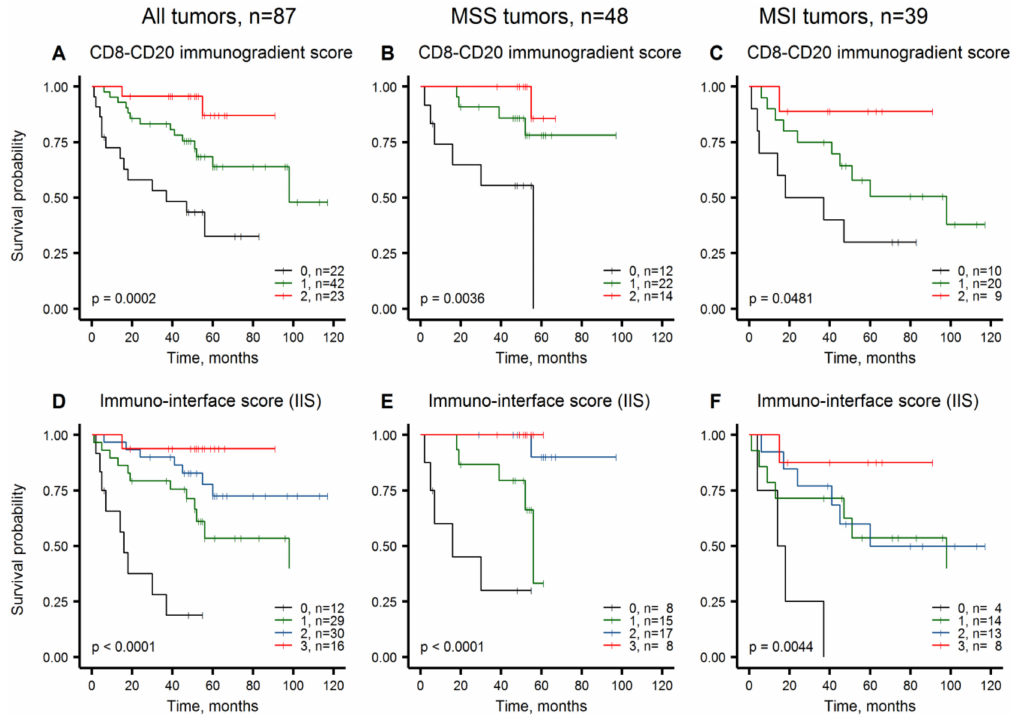
Figure 3. Kaplan-Meier plots representing overall survival probabilities obtained by the combinations of Immunogradient and histology indicators, in all tumors, MSS tumors and MSI tumors, respectively. ( A – C ): CD8-CD20 Immunogradient score; ( D – F ): immuno-interface